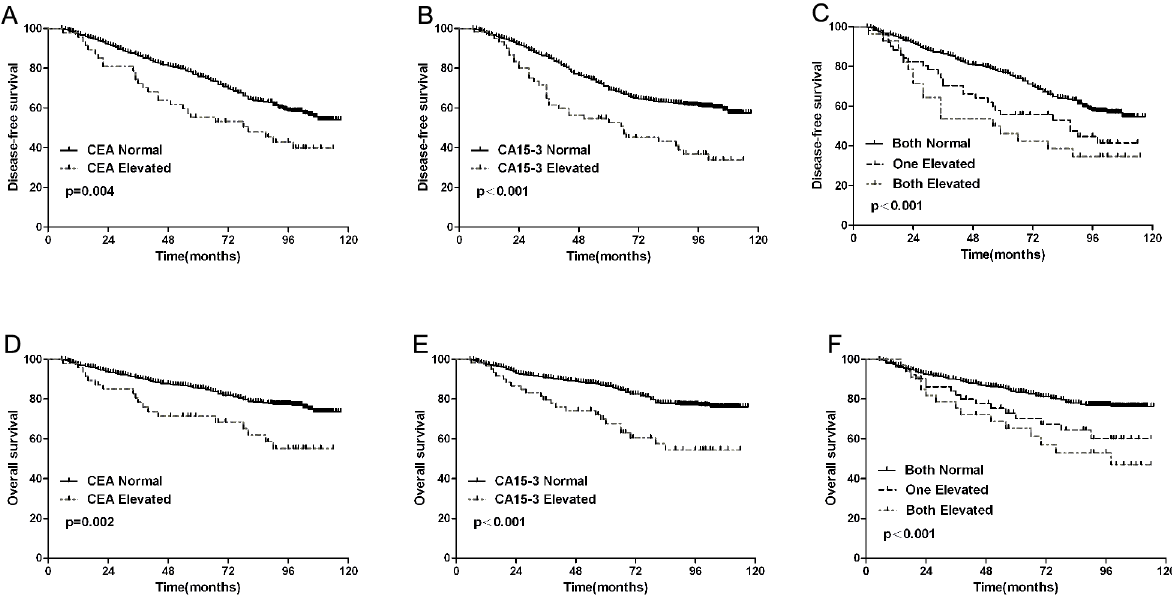
Fig 1. Kaplan-Meier survival curves of patients with normal or elevated CEA and CA15-3 levels. Disease-free survival (DFS) according to carcinoembryonic antigen (CEA) (A) and cancer antigen 15 – 3 (CA15-3) (B). Overall survival (OS) according to CEA(D) and CA15-3(E). DFS according to the combination of both marker levels(C) and OS according to the combination of both marker levels (F).